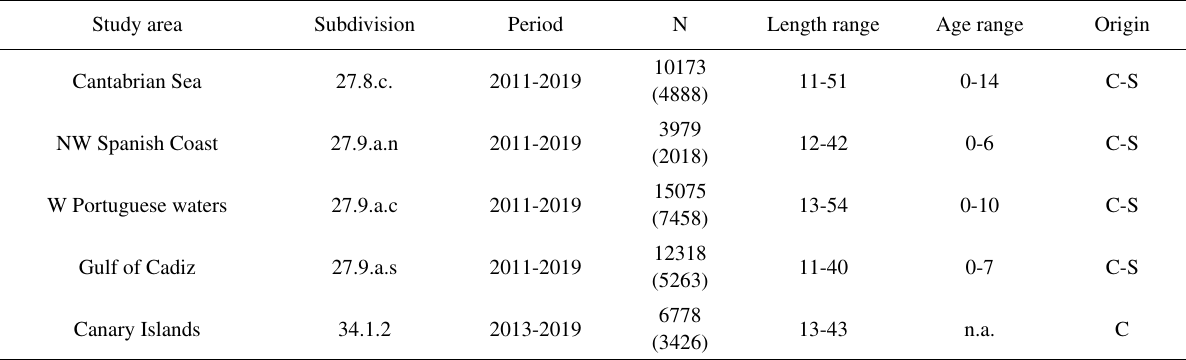
Table 1. – Description of the dataset used in the present study, including study area. Subdivision, FAO code of the study areas; Period, range of sampled years; N, number of sampled specimens (number of sampled females); Length range, total length range of sampled specimens (cm); Age range, age range of sampled specimens (years); Origin, C-commercial landings; S-scientific surveys; n.a., not available. Study area Subdivision Period N Length range Age range